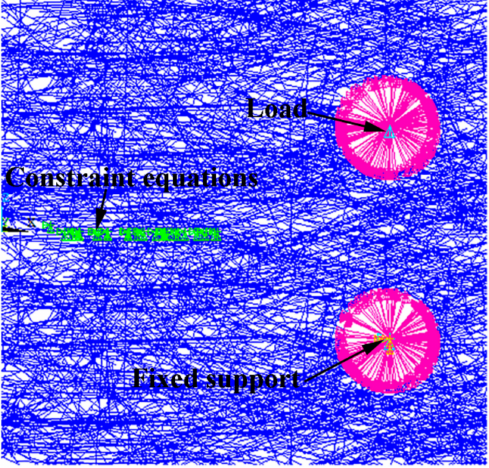
Figure 7. Constraint equations, load and fixed support shown in the FE